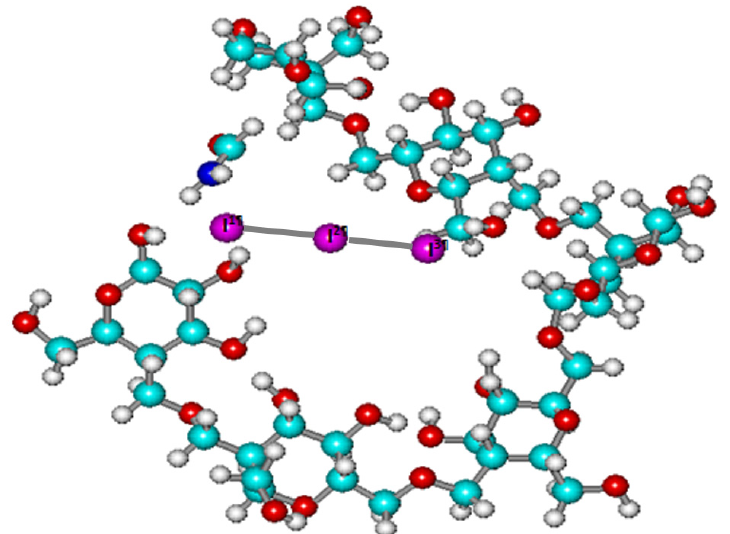
Figure 4. Complex III. Triiodide in the dextrin ring. Blue balls are carbon atoms, red—oxygen, dark blue—nitrogen, violet—iodine, and white balls—hydrogen atoms.